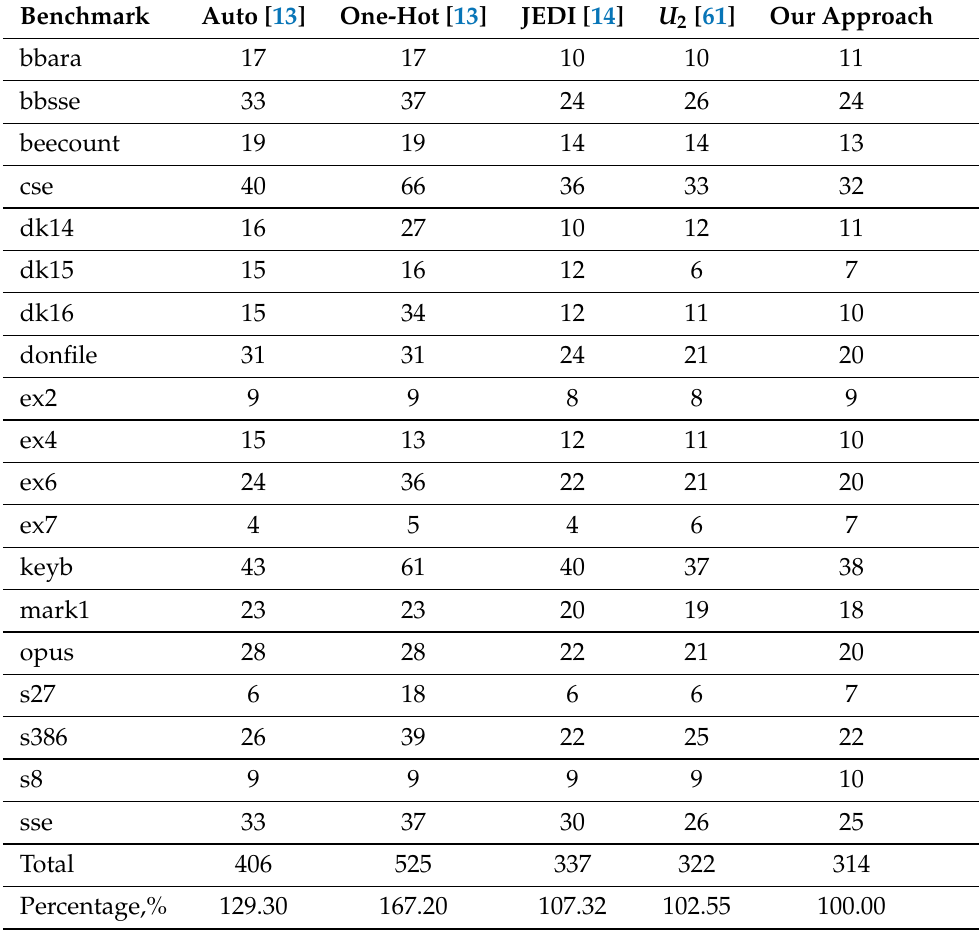
Table 10. Experimental results (LUT counts for benchmarks of